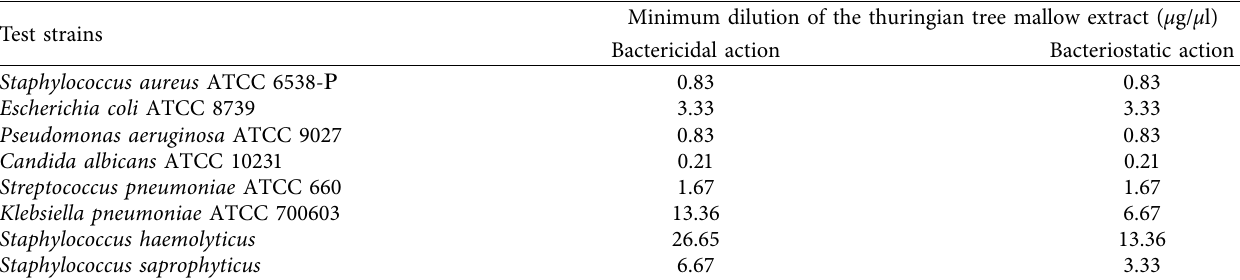
2 extraction) obtained by the method of serial dilution. Minimum dilution of the thuringian tree mallow extract ( μ g/ μ l) Bactericidal action Bacteriostatic action